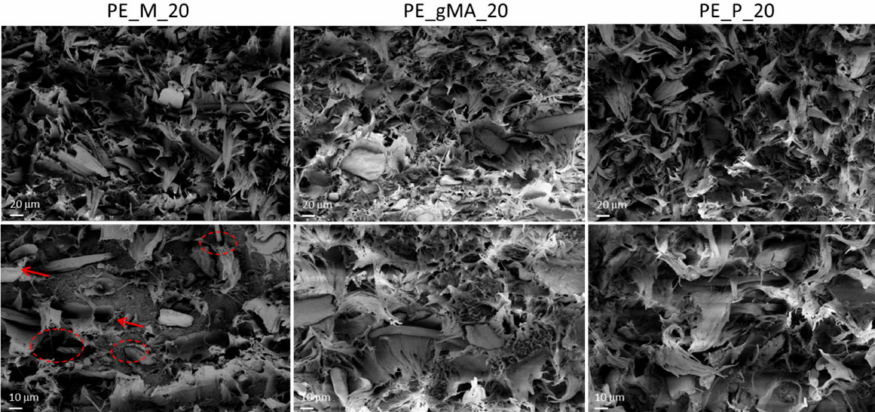
Figure 3. FESEM images of bulk BioPE_CSS composites with 20 wt % of unmodified, alkali and palmitoyl chloride treated